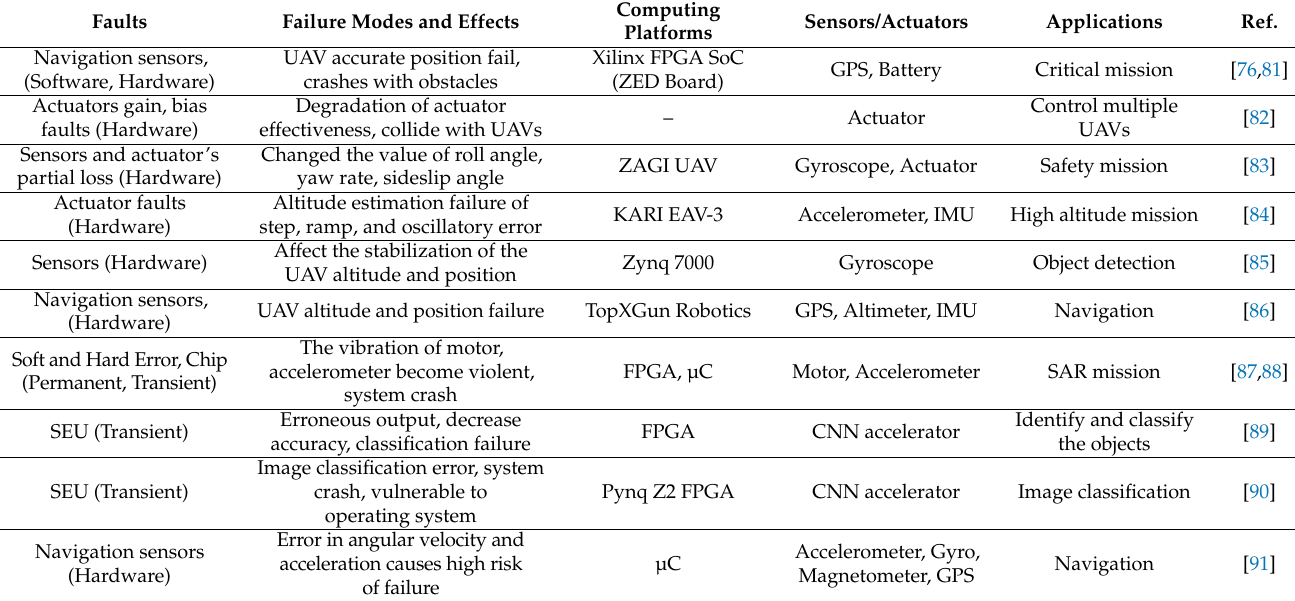
Table 6. Summary of fault and failure modes in